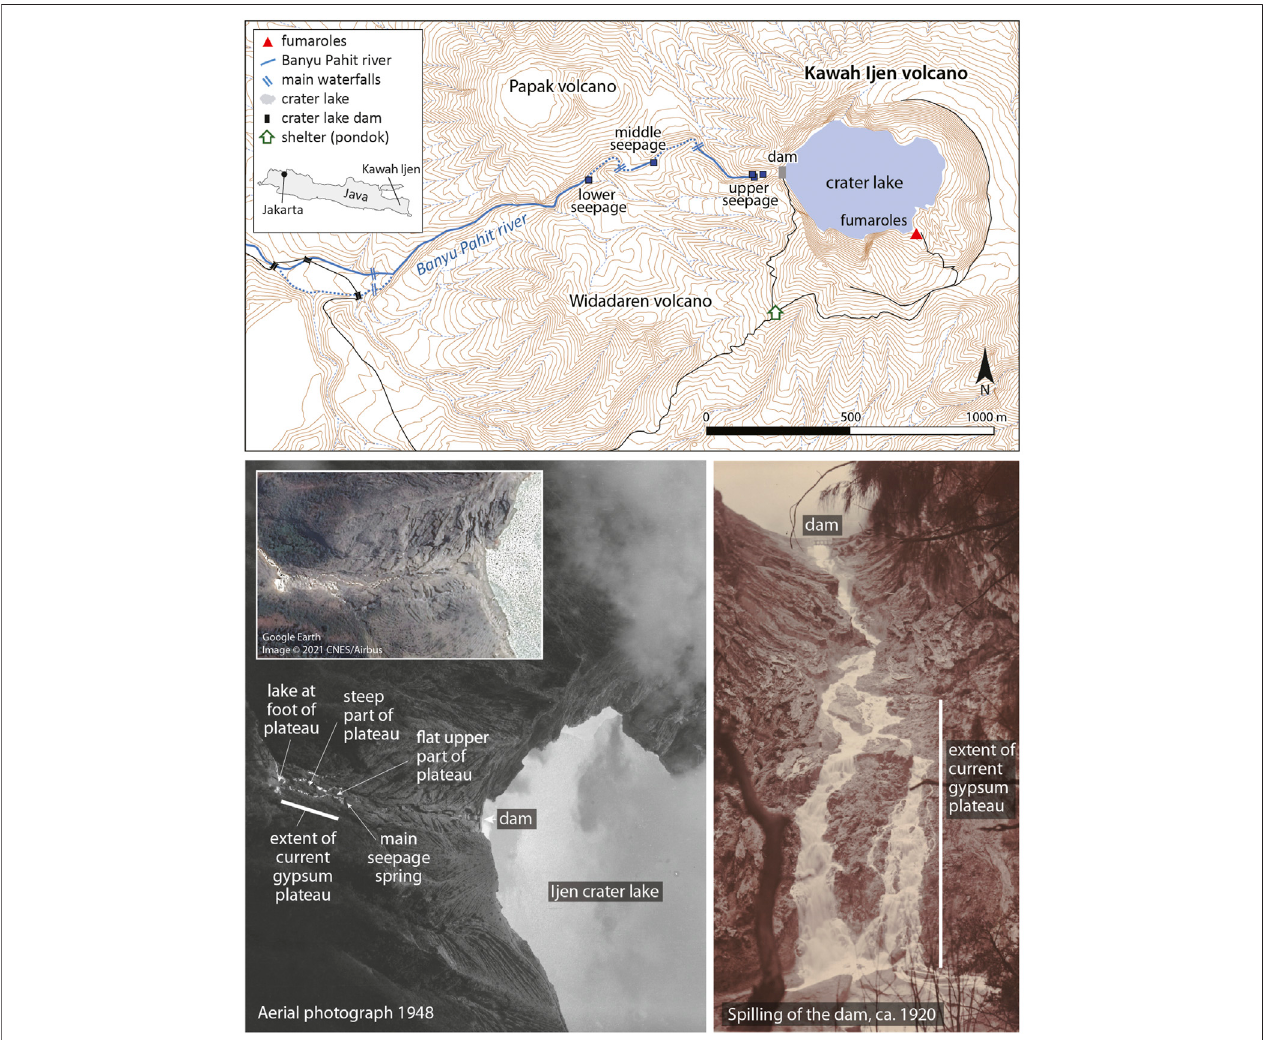
FIGURE 1 | (A) . Topographic map showing the crater lake and upper Banyu Pait river valley of Kawah Ijen volcano, and its location in East Java. (B) . Aerial photograph showing the upper Banyu Pait river valley and the position of the gypsum plateau within it. The two main water channels on the plateau are also visible and are still present today as shown in the inset satellite image from March 2014 (C) . Photograph showing the upper Banyu Pait valley up to the dam during an episode of spilling around 1920. No gypsum is evident in this photograph, suggesting the plateau formed post-1920. The photographs shown in b and c are from the KITLV image library hosted by Leiden